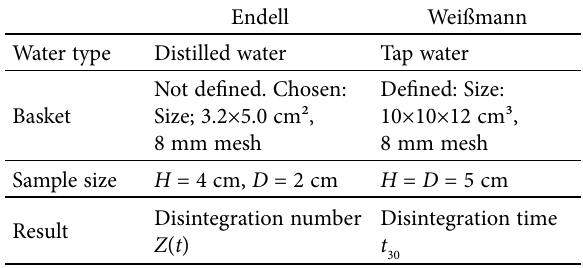
Figure 4. After entering the results of the three test series into this diagram the disintegration number t calculated with Equations (2)–(5).